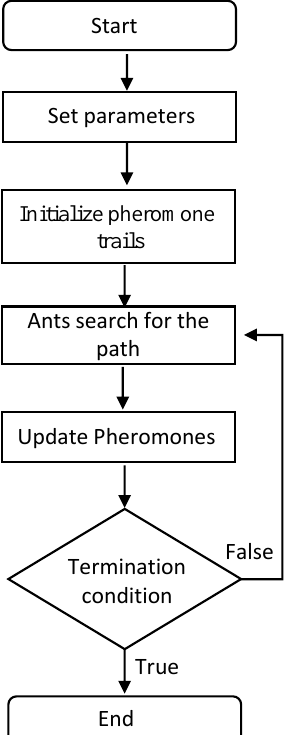
Figure 6. Flow of the ACO